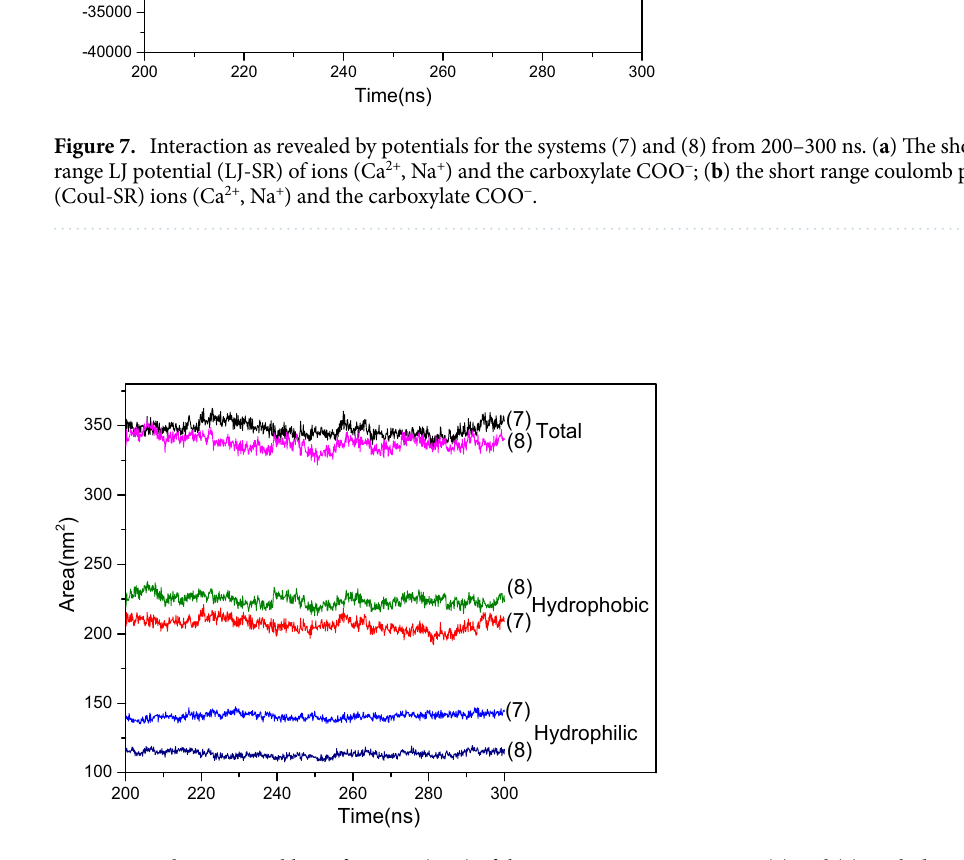
Figure 8. Solvent accessible surface area (sasa) of the group 2NapFF in systems (7) and (8). Including the total, hydrophobic, and hydrophilic sasa, for the